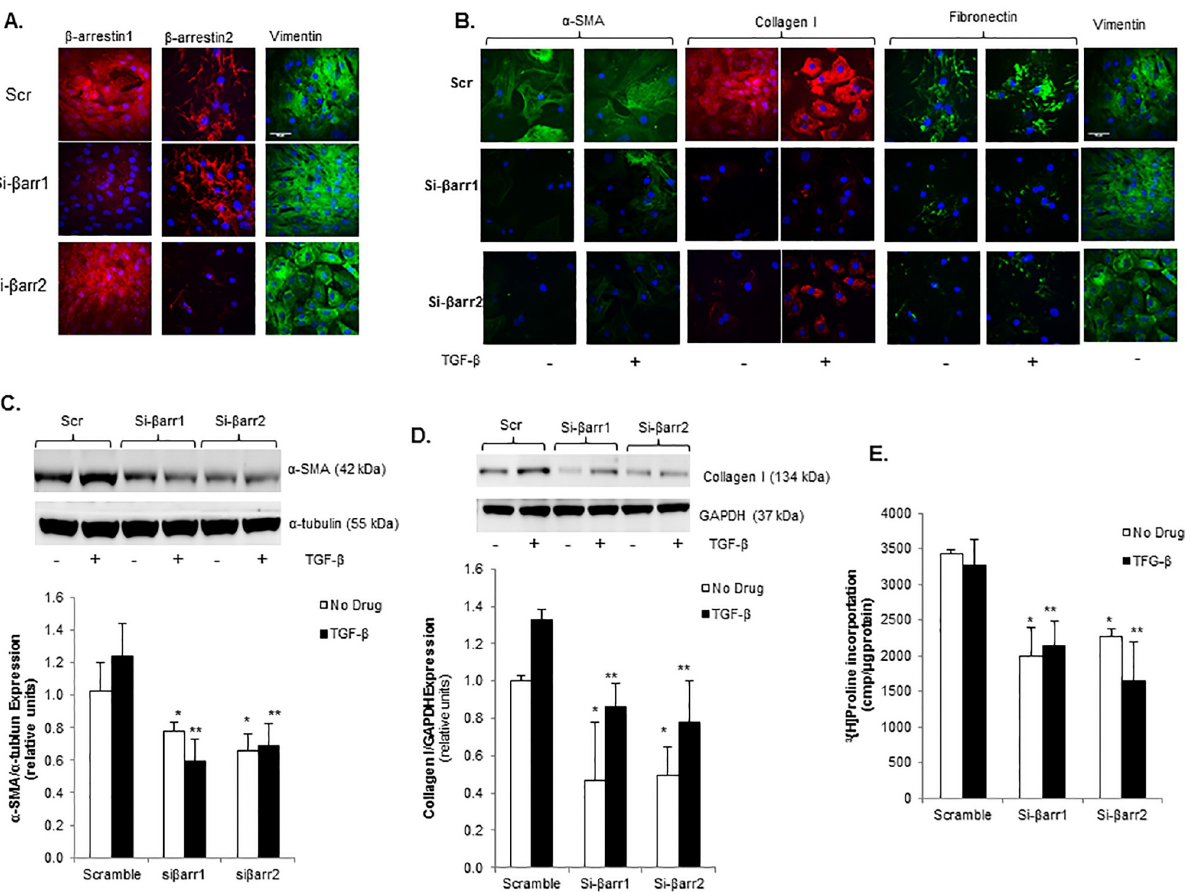
Fig 5. β -arrestin knockdown inhibits myofibroblast transformation and collagen synthesis in cardiac fibroblasts isolated post-myocardial infarction. A. Confocal images showing β -arrestin1 and 2 stained red with Alexa Fluor 594 dye and vimentin stained green with FITC in rat cardiac fibroblasts isolated 8 weeks post-infarction treated with siRNA for β -arrestin1 (si- β arr1), β -arrestin2 (si- β arr2), or scrambled control (Scr) demonstrating successful knockdown of β -arrestins. Nuclei stained blue with DAPI. B. Confocal images showing Collagen I stained red with Alexa Fluor 594 dye and α -SMA, Fibronectin, and Vimentin stained green with FITC in 8 week post-MI CF following siRNA-mediated knockdown of β - arrestin1 and 2 treated with TGF- β vs. no drug. Nuclei stained blue with DAPI. C. Representative immunoblot (upper panel) showing decreased basal and TGF- β -stimulated α -SMA expression in 8 week post-MI CF following Si- β arr1 and Si- β arr2 treatment vs. scramble control (Scr). This membrane was stripped and re-probed for α -tubulin. Densitometric analysis shown below. � p < 0.025 vs. Scr No Drug, �� p < 0.01 vs. Scr TGF- β ; n = 4–5 in each group. D. Representative immunoblot (upper panel) showing decreased basal and TGF- β -stimulated Collagen I expression in 8 week post-MI CF following Si- β arr1 and Si- β arr2 treatment vs. scramble control (Scr). Membrane was cut based on the molecular weight and separately probed with Collagen I and GAPDH. Densitometric analysis shown below. � p < 0.04 vs. Scr No Drug, �� p < 0.005 vs. Scr No Drug; n = 4–5 in each group. E. Collagen synthesis in 8 week post-MI CF following siRNA knockdown of β -arrestin1 and 2 under basal conditions and TGF- β stimulation. � p < 0.02 vs. Scr No Drug, �� p < 0.02 Scr TGF- β ; n = 3 in each